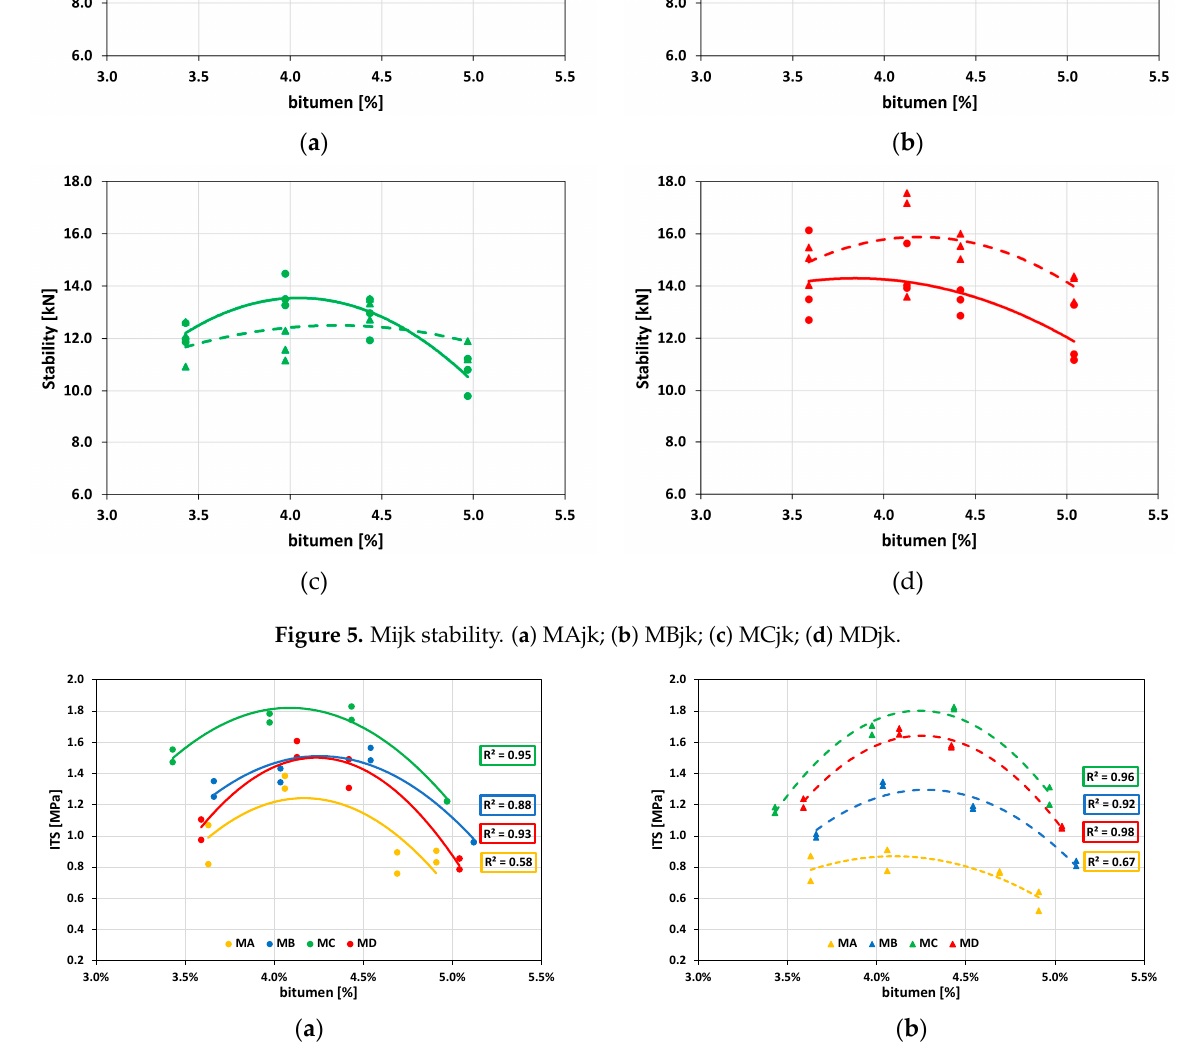
Figure 6. Mijk ITS curves. ( a ) MijM; ( b ) MijG. Figure 6 highlights that the MAjk envelope curve is the worst in terms of ITS.